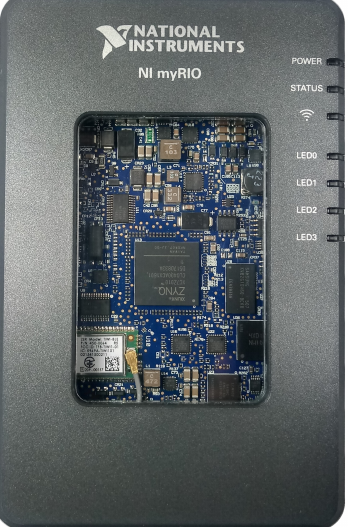
Figure 4. NI myRIO